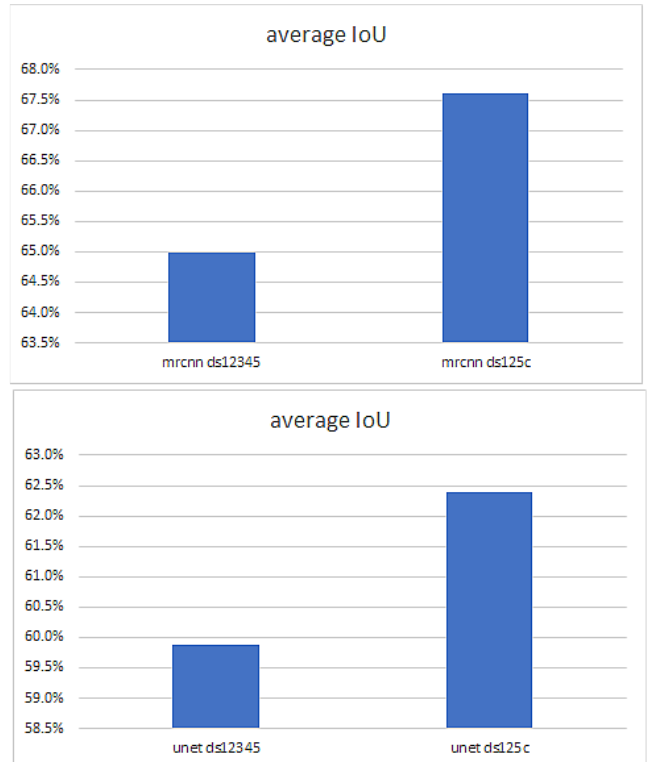
Figure 13. The effect of the annotation accuracy tested on both Mask R-CNN ( above ) and U-NET